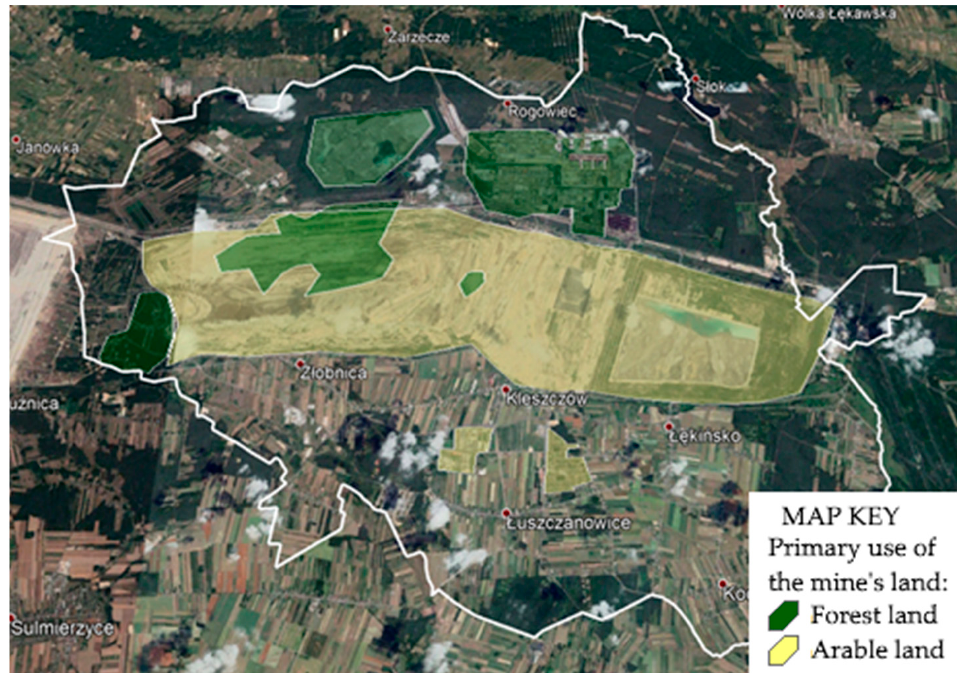
Figure 7. Change in land use in the period 1980–2020 in the territory of the commune of Kleszczów. Note: The white line marks the exact location of the open-cast lignite mine in the municipality of Kleszczów . (Source: own elaboration).